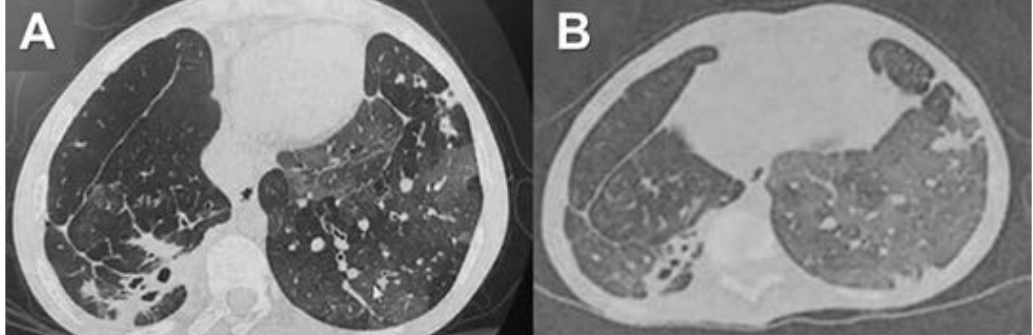
Fig. 2. A. CT-scan of September 2019. B. CT-scan of April 2020. Both show patched opacities in the ground glass of subpleural